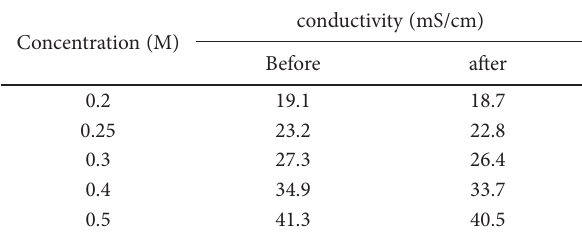
Table 8. The resin absorption capacities (+/- 0.5 mmol/g) estimated from the measured absorption from aqueous NaCl solutions (i.e.